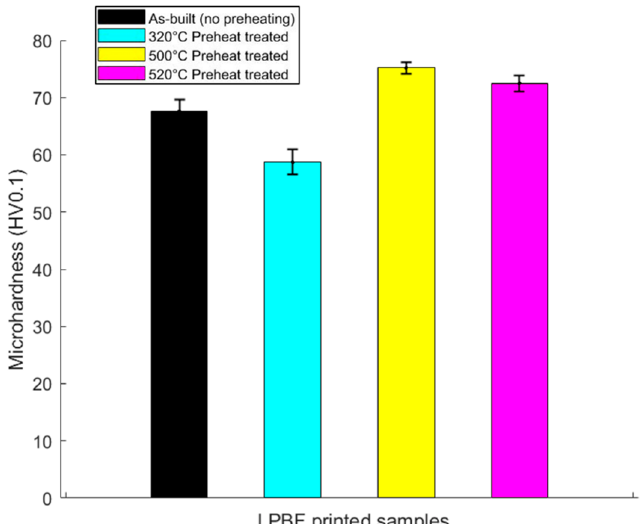
Figure 10. Microhardness of 520 ◦ C preheat-treated sample [20]. Microhardness comparison of as-built, 320 ◦ C and 500 ◦ C preheat-treated samples showing elevated microhardness of the 500 ◦ C sample due to higher T 1 volume fraction, followed by the as-built samples, which is attributed to residual stress build-up.